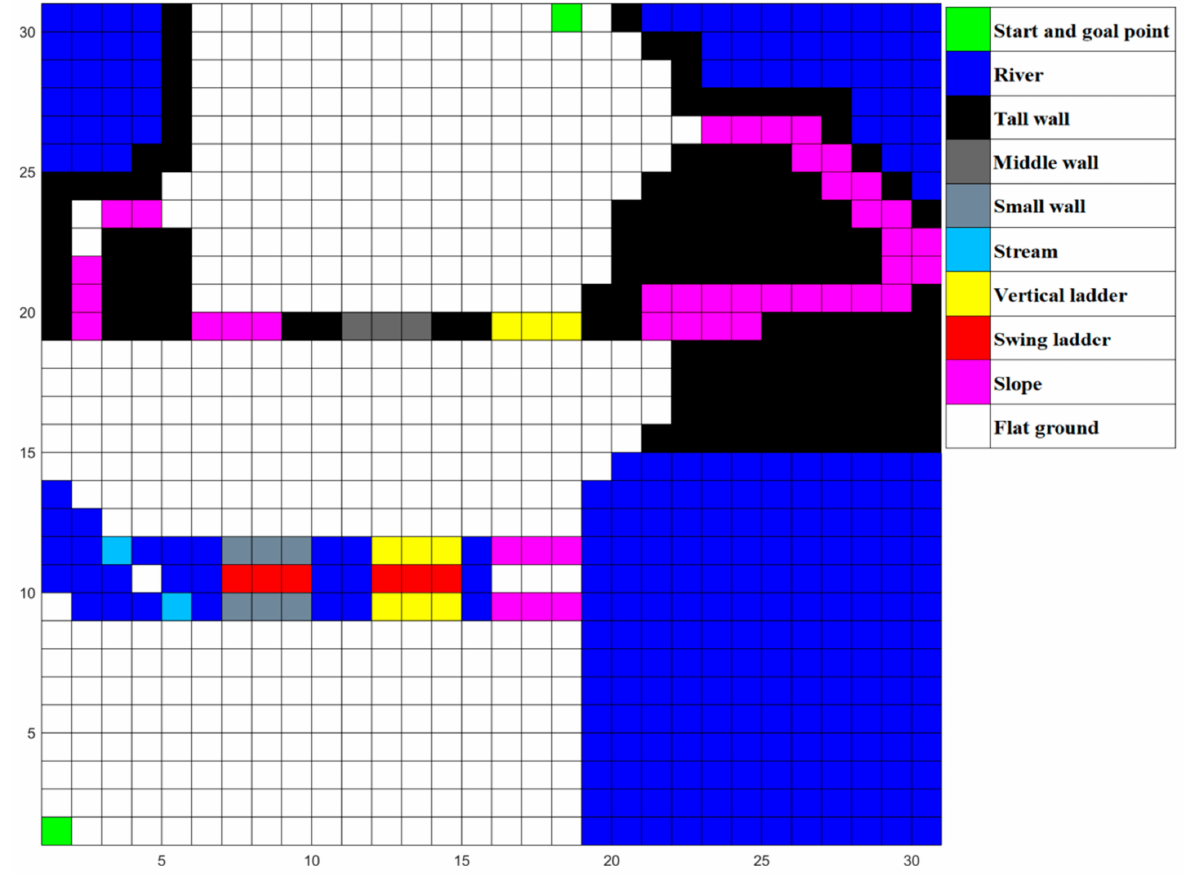
Figure 21. The abstracted 30 × 30 grid map of the simulated environment.